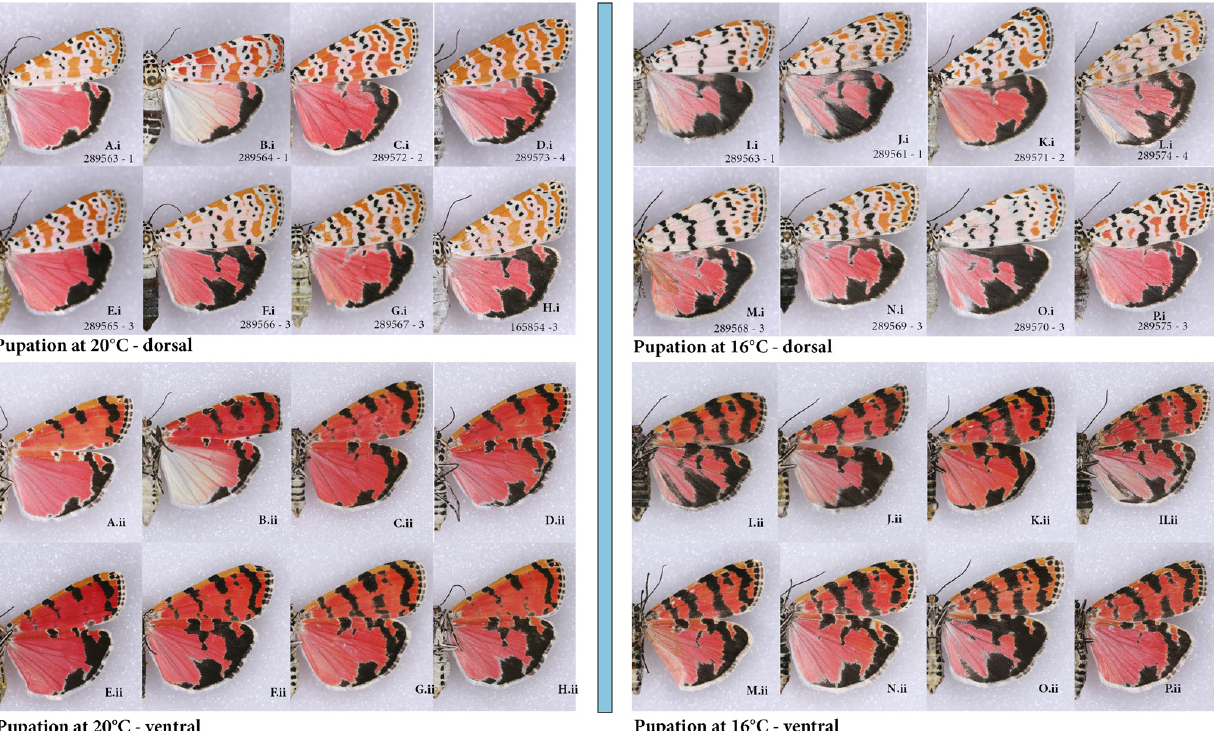
Figure 14. Cold-induced wing pattern changes in the ornate bella moth, Utetheisa ornatrix . ( A – H ) raised at 20℃; ( I – P ) raised in the last instar to adult at 16℃. ( i ) dorsal ( ii ) ventral; code following voucher # indicates brood